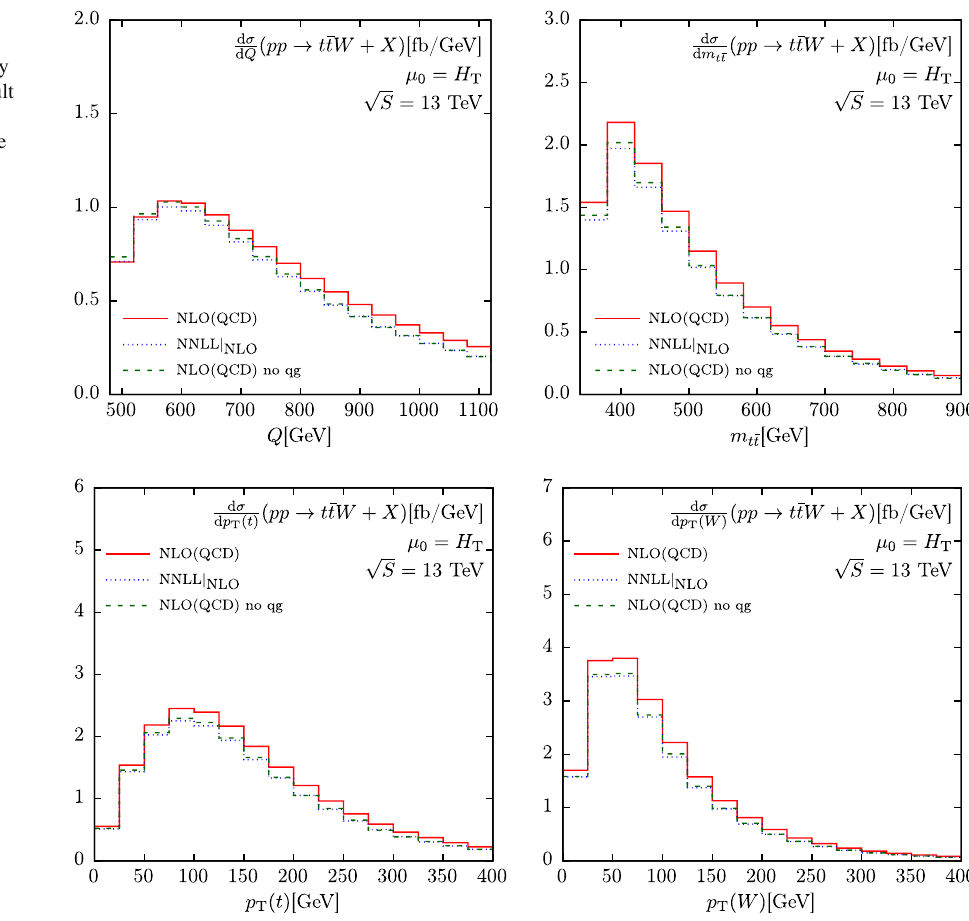
Fig. 6 Comparison between the expansion of the NNLL expression up to NLO accuracy in α s , the full NLO(QCD) result and the NLO(QCD) result without the qg channels for the pp → t ¯ tW differential distributions in Q and m t ¯ t